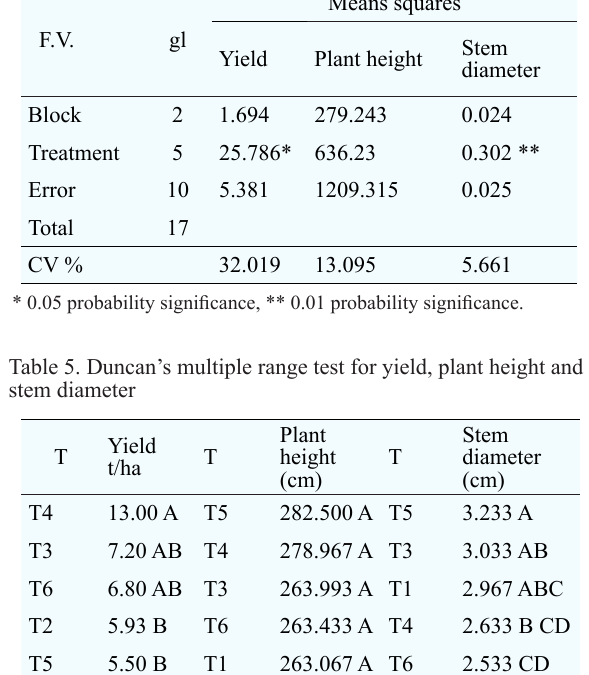
Table 4. Analysis of variance for yield (t/ha), plant height (cm) and stem diameter (cm) F.V.